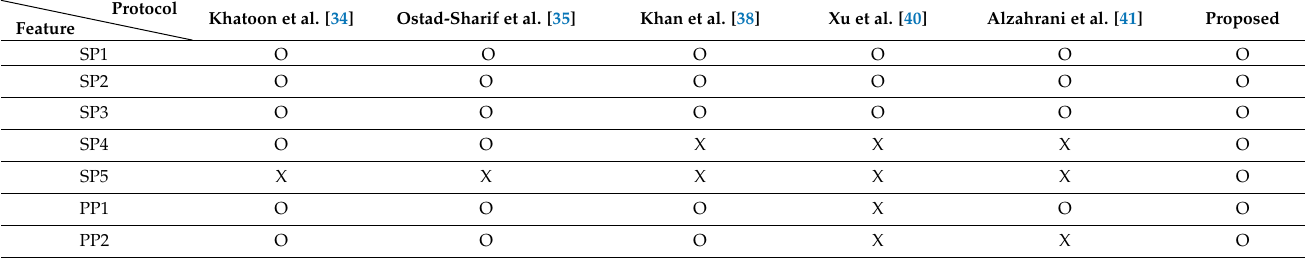
Table 2. Privacy and security feature comparison